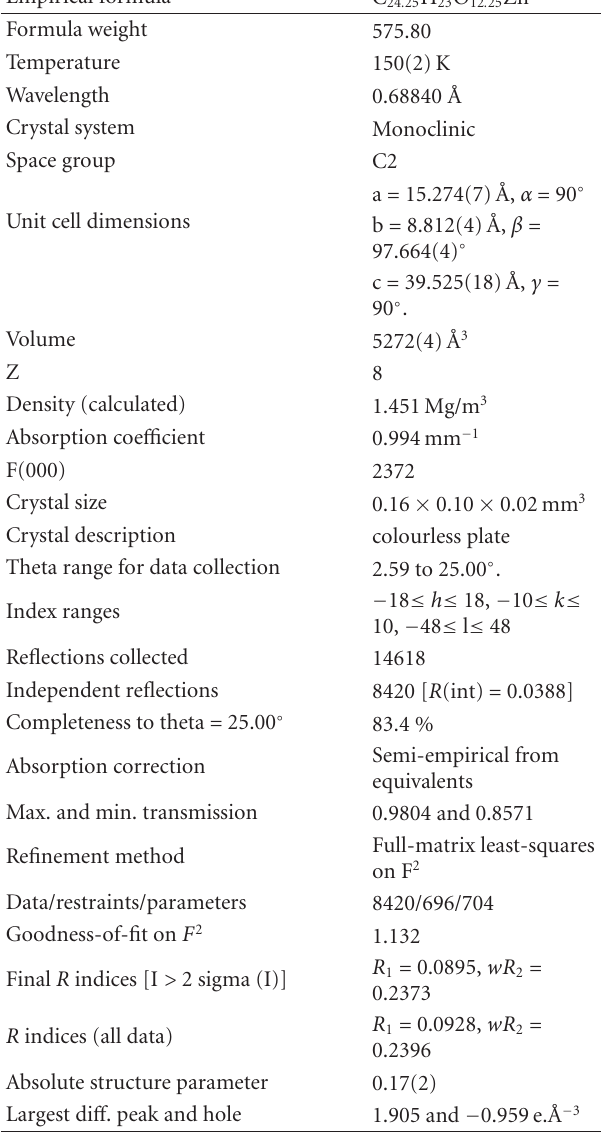
Table 1: Crystal data, structure refinement for